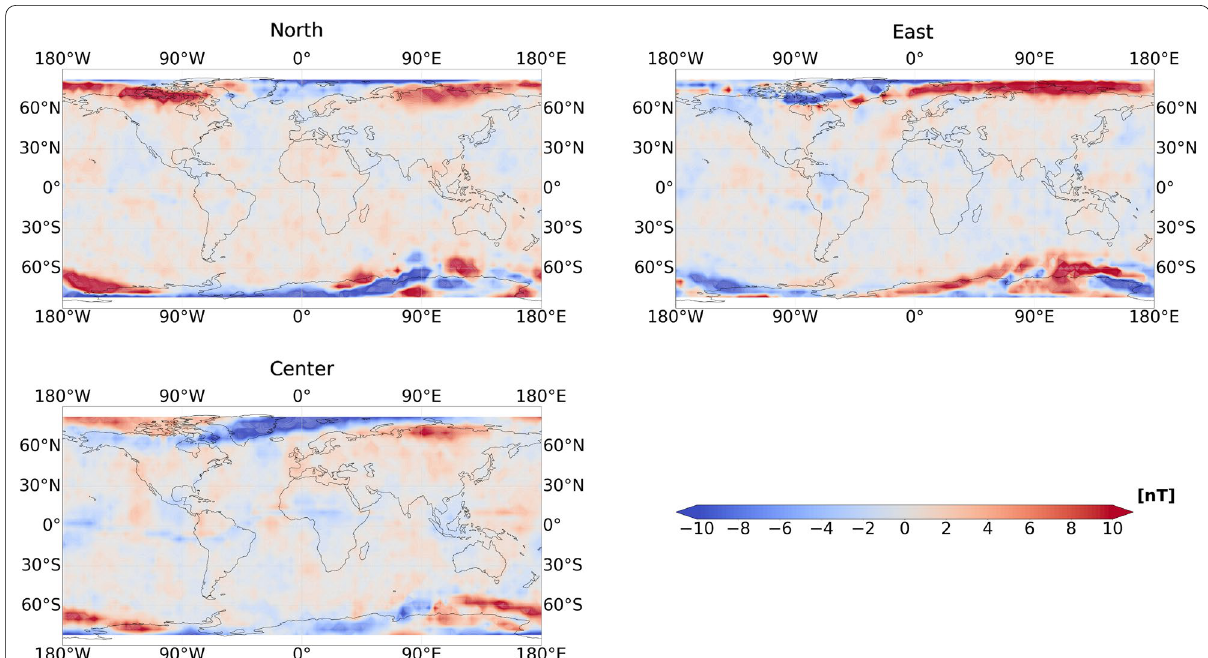
Fig. 3 Binned and averaged residual map between the calibrated platform magnetometers and the CHAOS‑7 reference model for the year 2012 in the NEC Frame, North component in top left, East in top right, Center in bottom left. The color scale for all panels is given in the bottom right, and saturation of color is achieved beyond ‑10 or 10 nT, respectively. Residuals are low while FAC structures remain